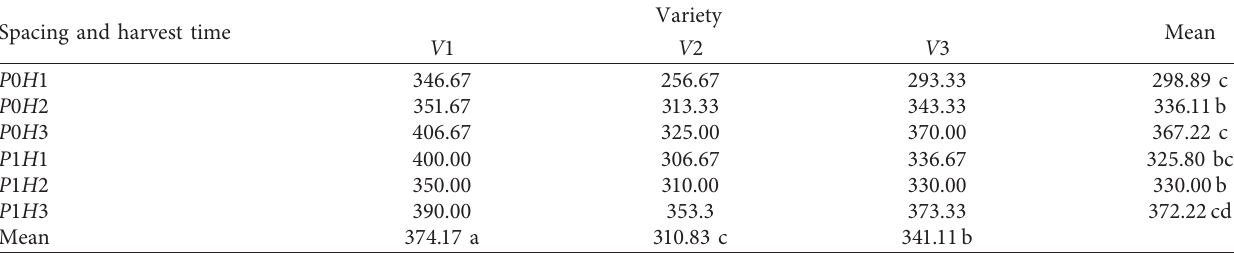
Table 6: Cob weights (gram/cob) of sweet corn of different varieties and at different harvest times. Spacing and harvest time